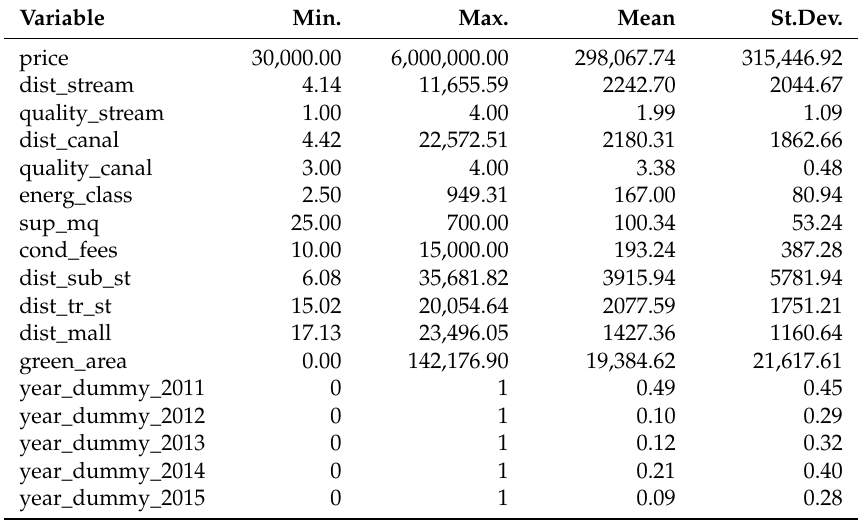
Table 2. Descriptive statistics of dichotomous